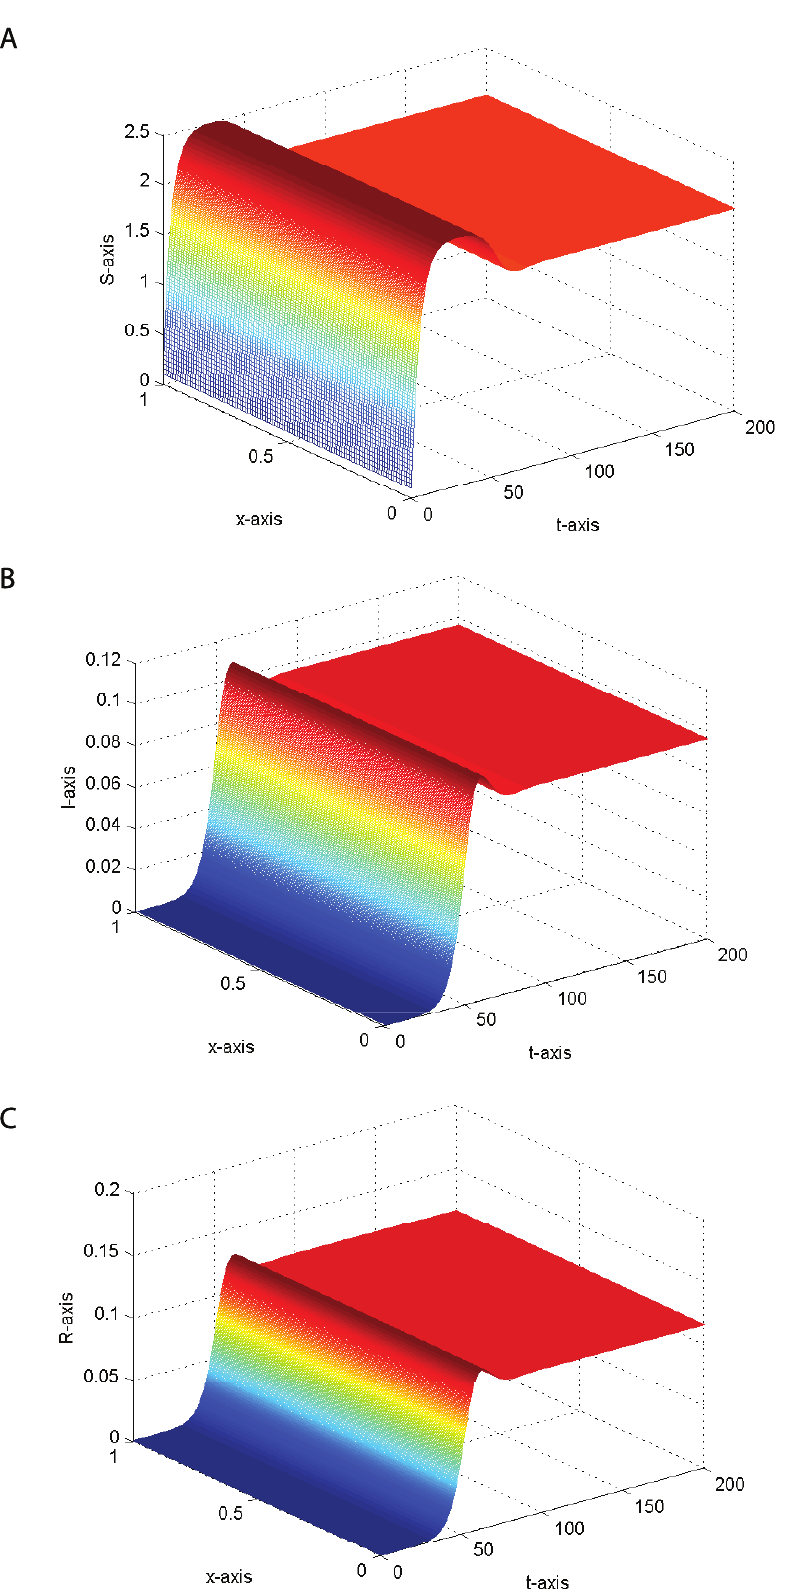
Figure 2. The temporal solution found by numerical integration of problem (0.3) under conditions (0.4) and (0.15) with B ~ 0 : 5 , b ~ 0 : 5 , ª ~ 0 : 6 , a ~ 0 : 1 , m 1 ~ 0 : 2 , m 2 ~ 0 : 4 , m 3 ~ 0 : 5 , D ~ 10 , t ~ 0 : 2 and d 1 ( x , t ) ~ 0 : 1 , d 2 ( x , t ) ~ 0 : 001 , d 3 ( x , t ) ~ 0 : 0001 , t [ ½ { 0 : 2 , 0 (cid:2) .